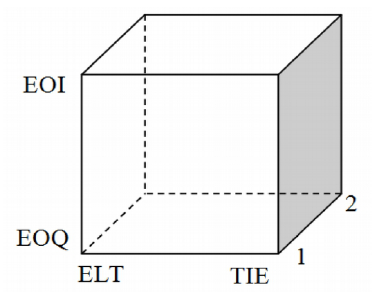
Figure 2. DoE: Principal factorial plan